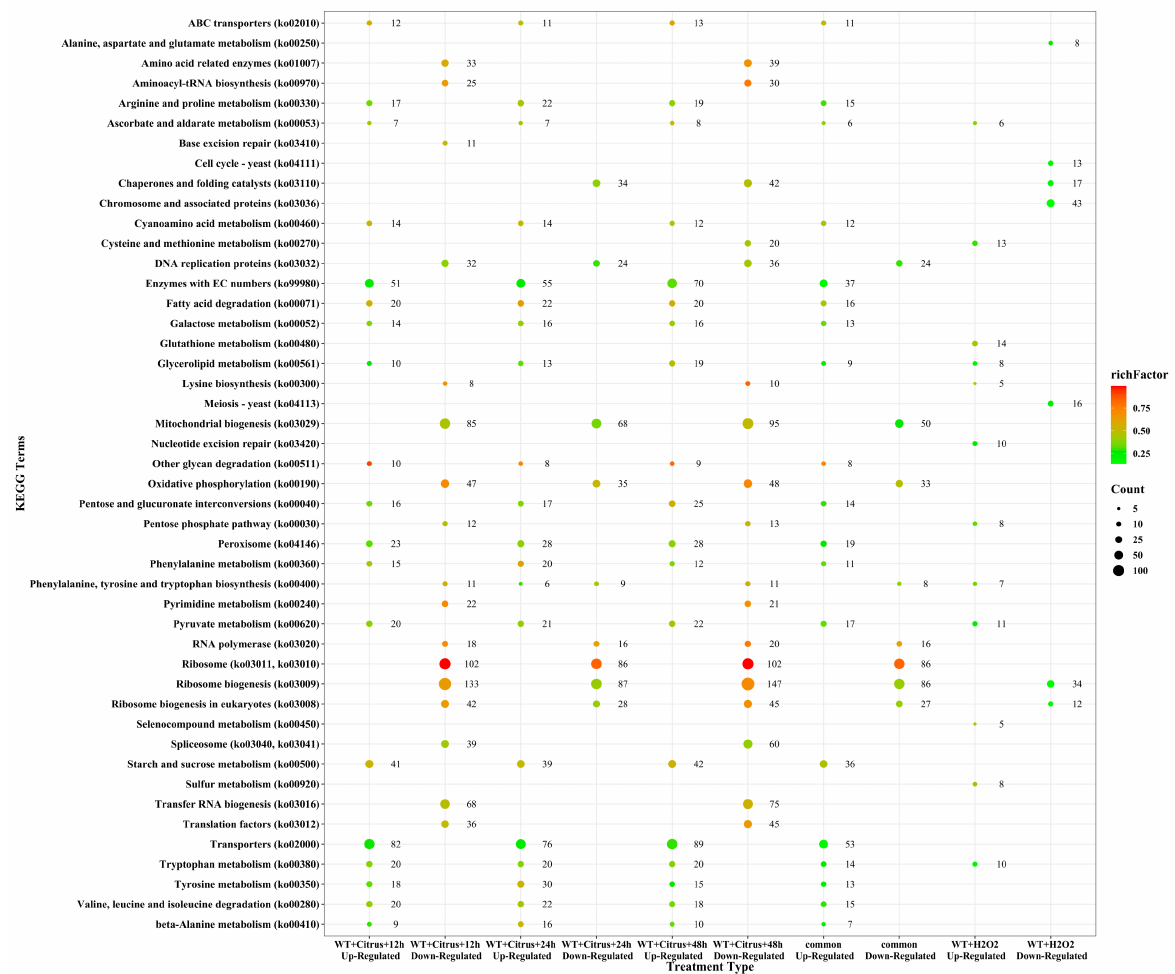
Figure 6. Comparative KEGG pathways analysis was conducted on the differentially expressed genes (DEGs) between the transcriptome of Alternaria alternata and A. alternata inoculated on citrus leaves at 12 h, 24 h, 48 h, common (differentially expressed genes that are commonly up-regulated or down-regulated in the three infection stages), and A. alternata under oxidative stress (WT + H 2 O 2 ). The x-axis of the graph indicates different mutants while the y-axis displays the KEGG pathway. The count, which is represented in the graph, stands for the number of differentially expressed genes enriched in the pathway. Moreover, the color in the graph reflects the enrichment factor of each